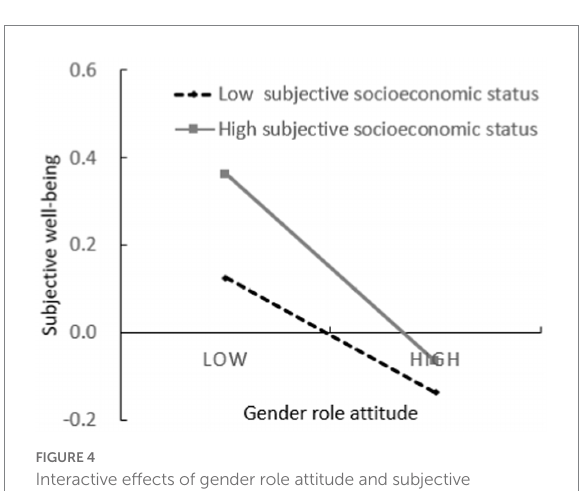
FIGURE 4 Interactive effects of gender role attitude and subjective economic status on subjective